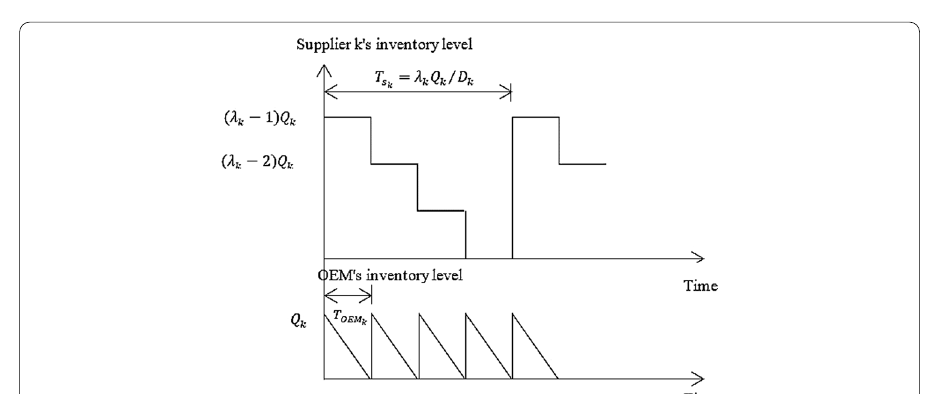
Fig. 2 Inventory levels for each supplier and the